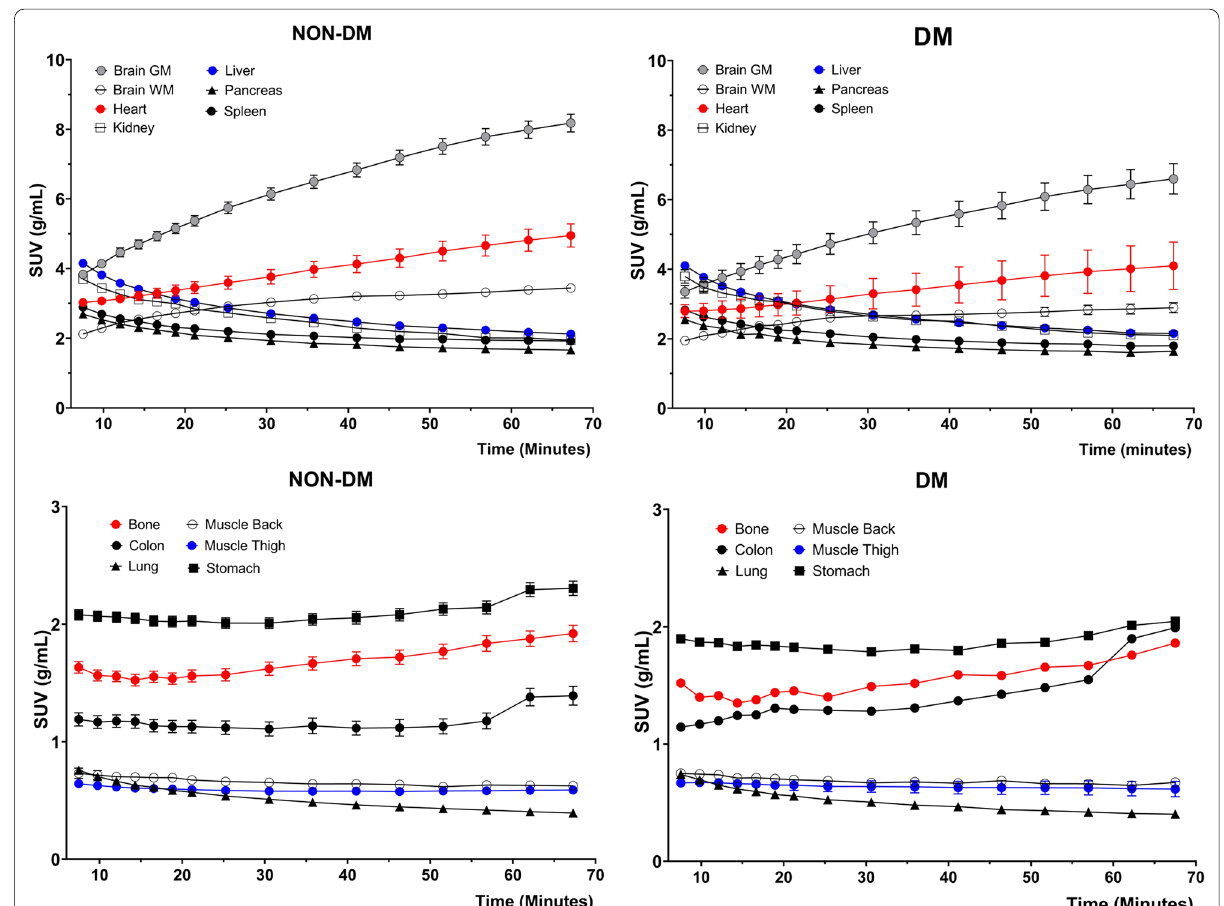
Fig. 4 Time-activity curves for the remaining 6–70 min of dynamic WB scanning. Represented values are mean and SEM of all 126 patients. The panels on the left side correspond to the patients without diabetes; the panels on the right side to the patients with